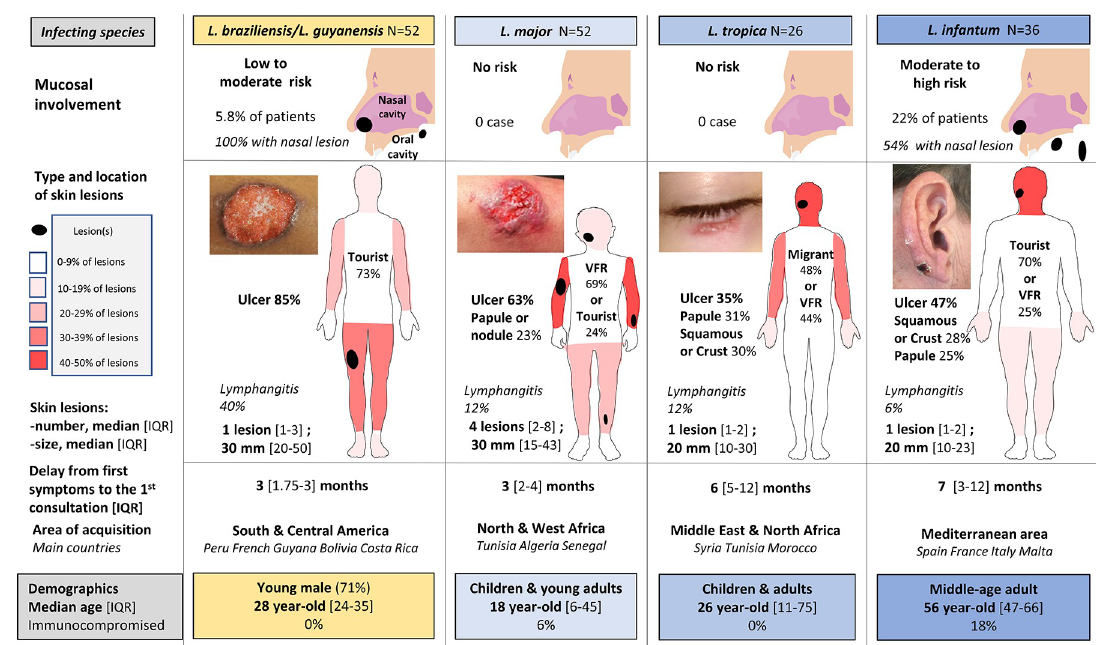
Fig 3. Comparative features of 166 cases of cutaneous leishmaniasis by main infecting species. Abbreviations: IQR, interquartile range; VFR, visiting friends and relatives.